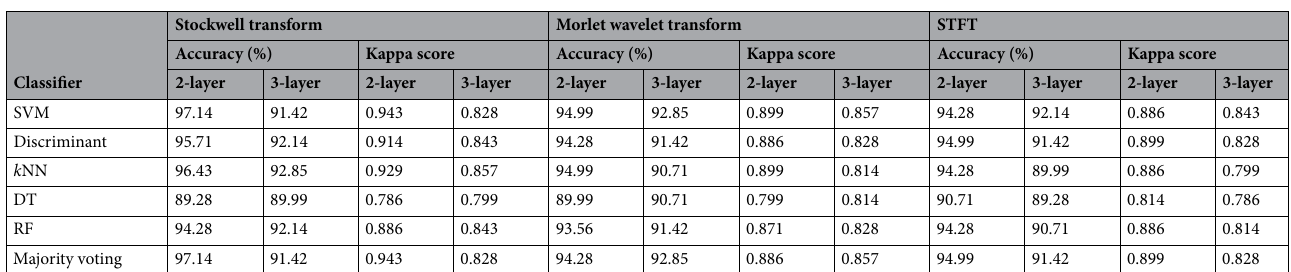
Table 2. Classification accuracy and Kappa scores for different machine learning approaches considering two- and three-layer CNN for Stockwell transform, Morlet wavelet transform and STFT on the dataset